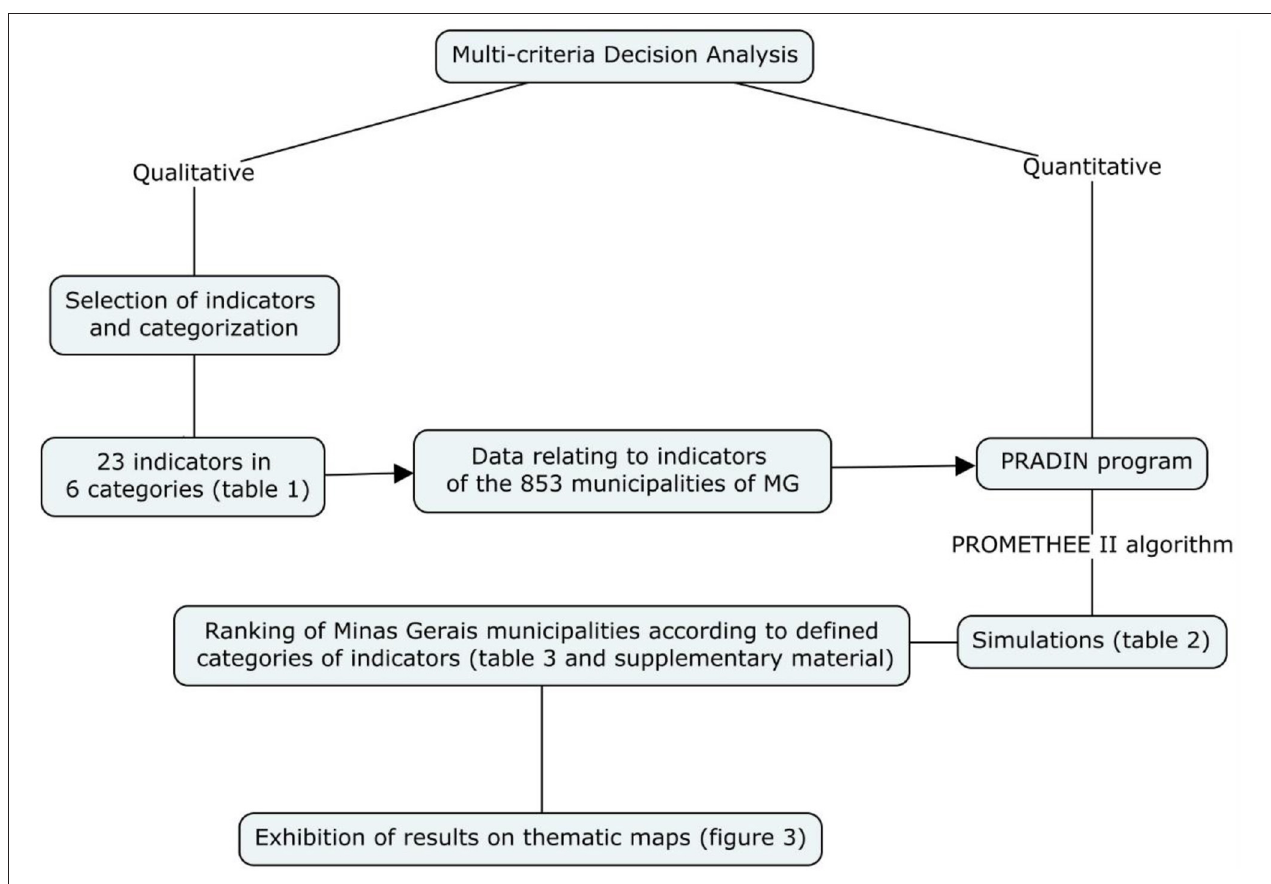
FIGURE 2 | Flowchart with step-by-step description of the